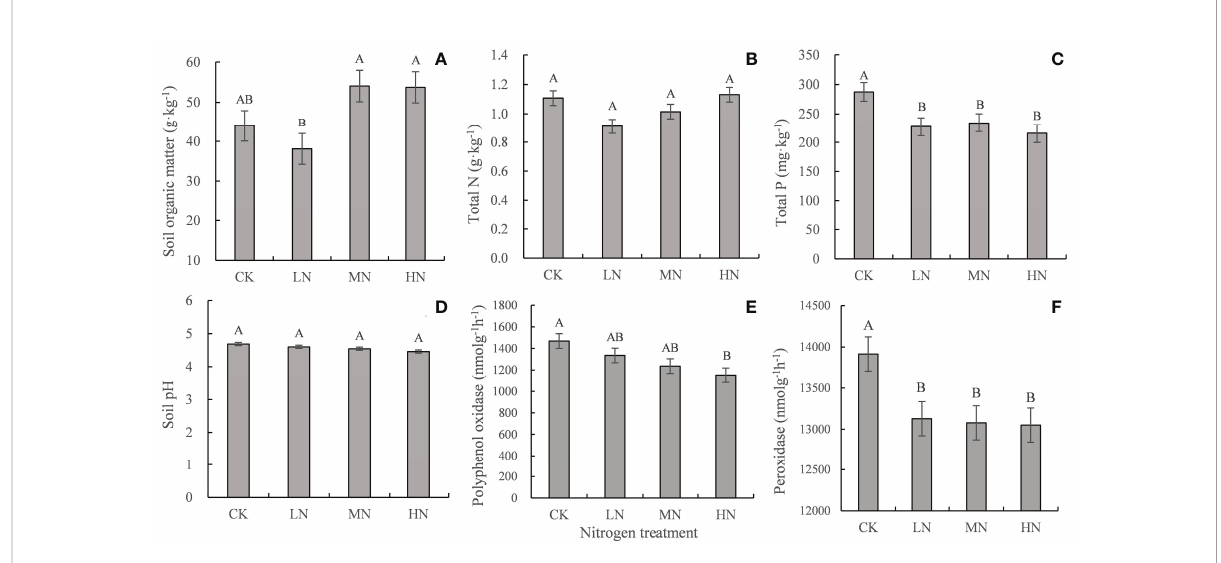
FIGURE 5 Soil properties and enzyme activities in the different treatments after 30 months of decomposition. Values represent the means ± SE (n = 3). Different capital letters indicate signi fi cant differences among different N addition treatments ( P < 0.05). CK (0 kg ha -1 year -1 ), LN (30 kg ha -1